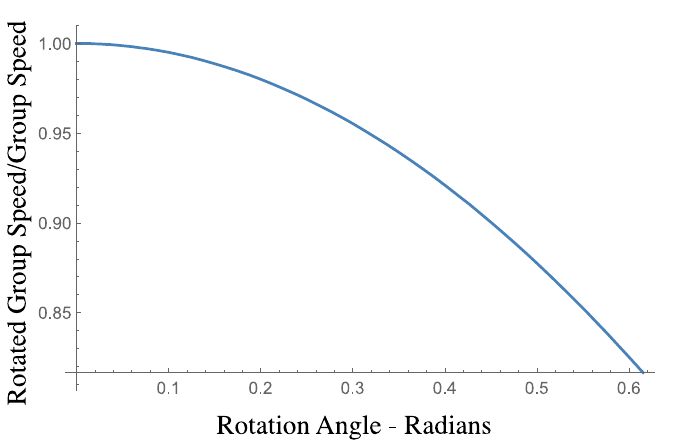
Figure 8. The group speed C g of the rotated 1+1 NLS solution is reduced with respect to that for the unrotated 1+1 NLS equation as the rotation angle varies between 0 and 35.2644 degrees.